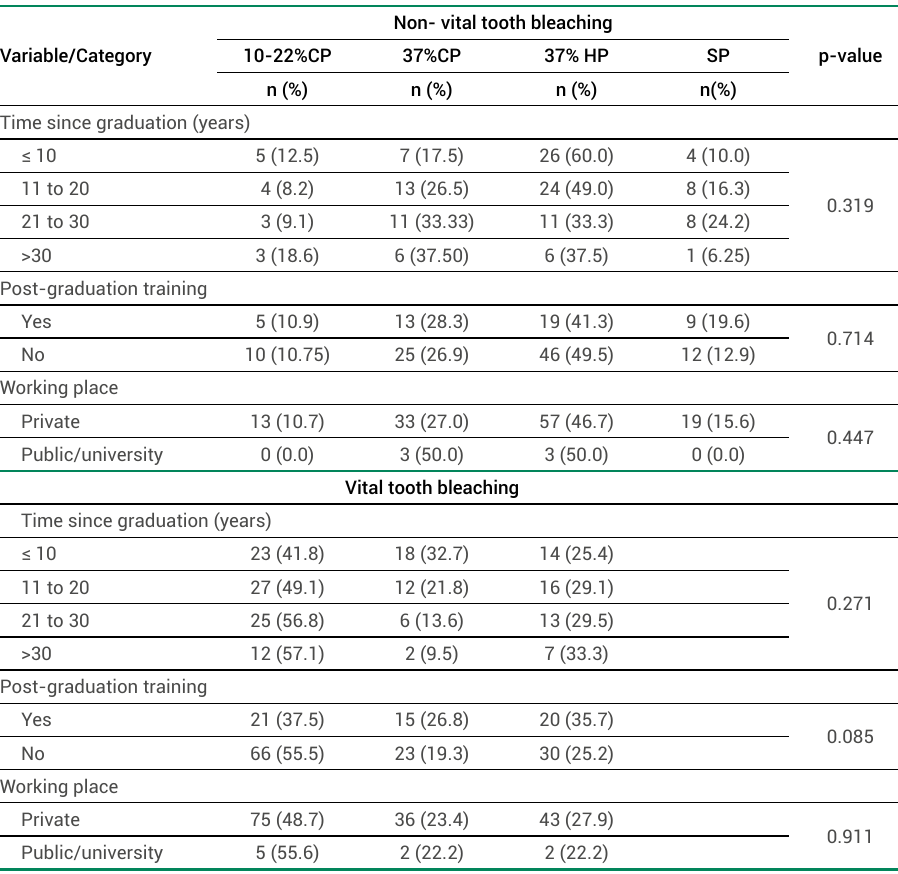
Non- vital tooth